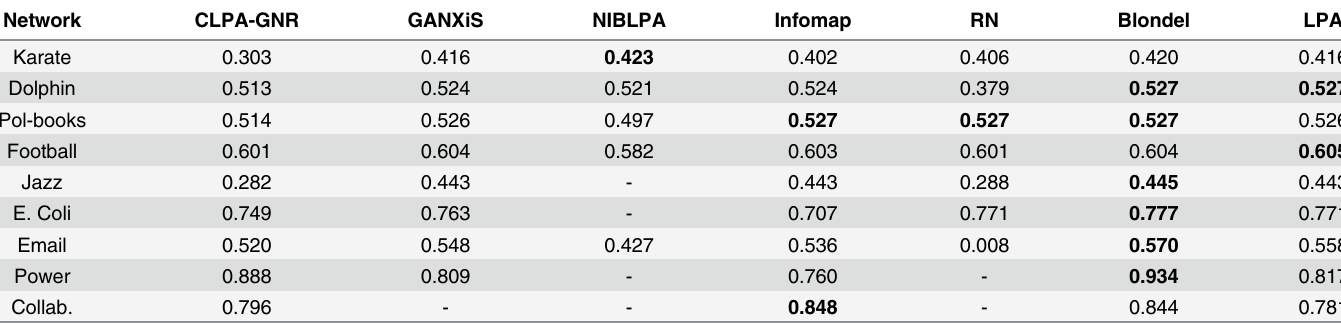
Table 7. The modularity ( Q ) for all the real-world networks. Bold values are the best detection algorithm for each network. Network